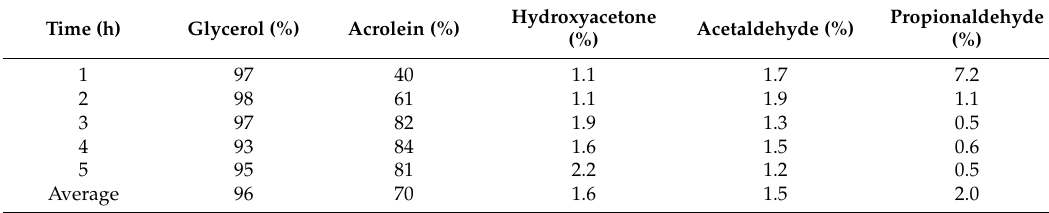
Table 18. Catalytic performance of WO 3 /TiO 2 .